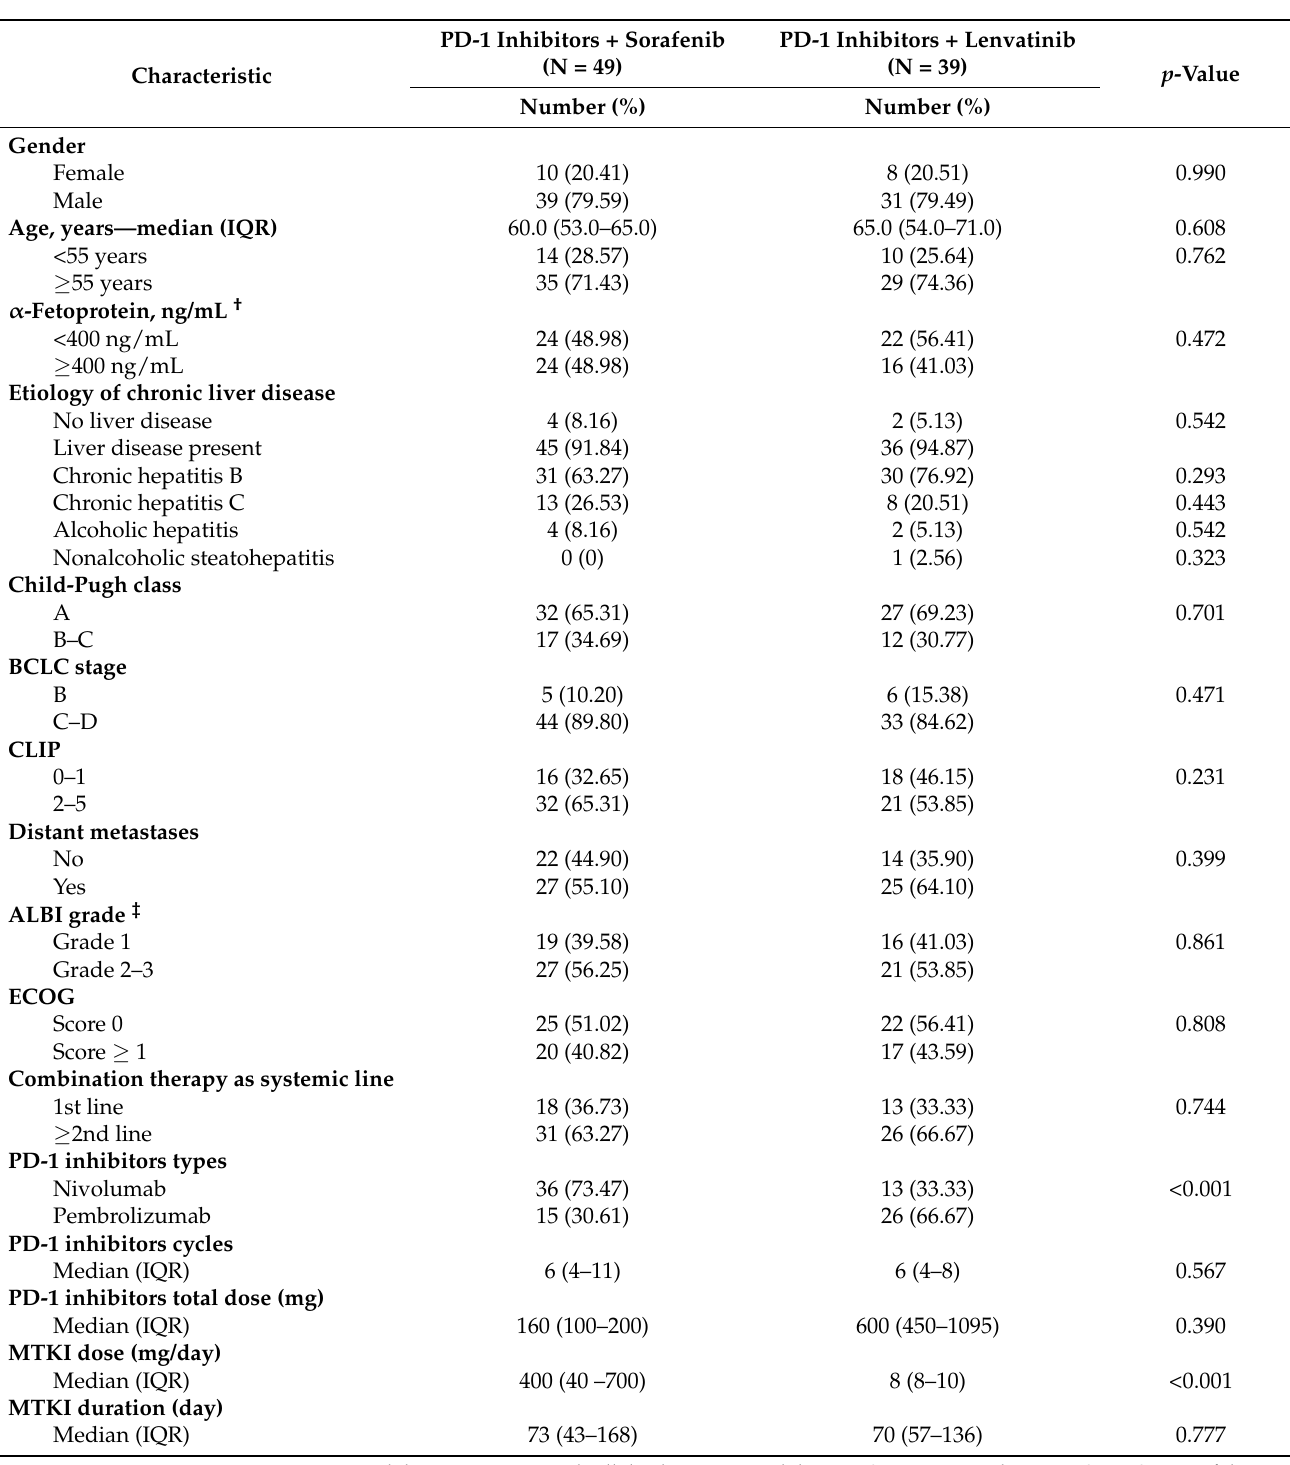
Table 1. Baseline characteristics of all 88 HCC patients who received immune checkpoint inhibitors combined with multitarget tyrosine kinase